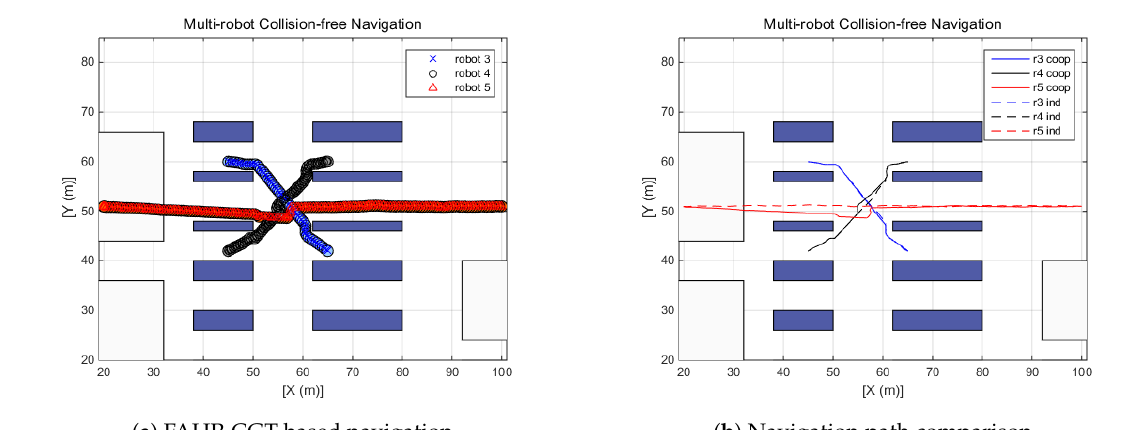
Figure 13. Scenario 2: Three-robot navigation.